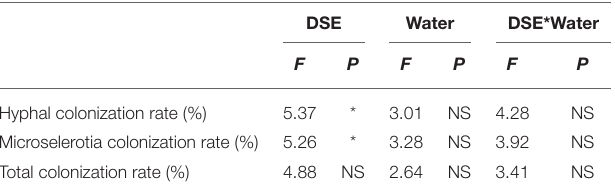
TABLE 1 | Two-way ANOVA of the effect of DSE and water condition on DSE colonization rate of Lycium ruthenicum